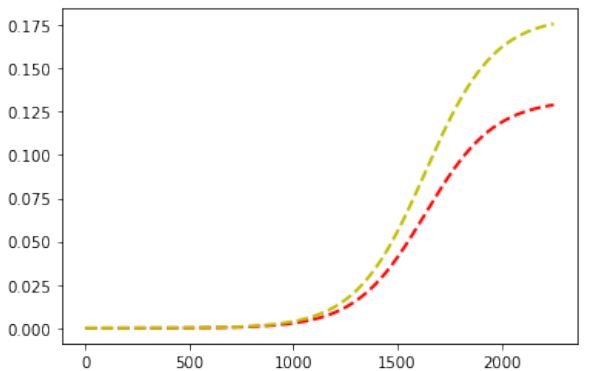
Figure 6. Mean system fitness growth of the cancer cell population without the effect of immune system (yellow line at the top) and taking into account the elimination of cancer cells by effector CTLs (red line at the